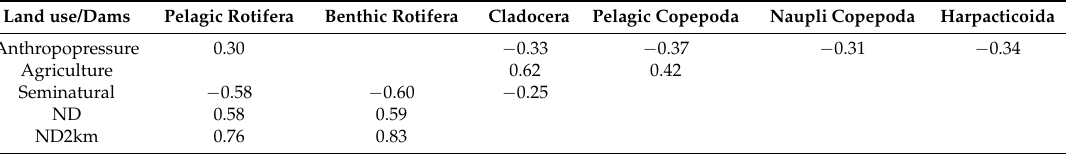
Table 7. Spearman significant correlations with Holm’s correction between zooplankton abundance and percentage land use in the local environment of the sites in the Corgo river (1 km buffer zone 2 km upstream) and between the number of dams above the site in the total river length and above 2 km upstream of the examined site (ND2km) ( p < 0.05).